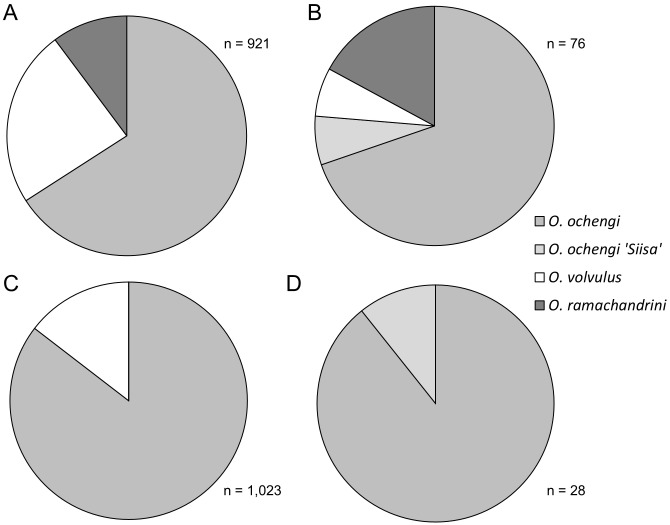
L3 species proportion.Species composition of infective third-stage larvae from S. damnosum s.l. at two foci in North Cameroon. White: O. volvulus; light grey: O. ochengi 'Siisa' type; medium grey: O. ochengi; dark grey: O. ramachandrini. A-B Soramboum, Vina du Nord. C-D Galim, Vina du Sud. Left side (A, C): morphological identification. Right side (B, D): PCR-based identification.